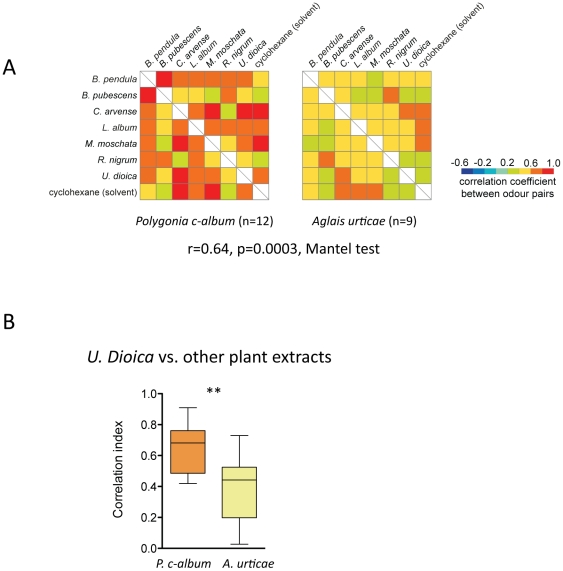
Responses to plant extracts. ASimilarity matrices of responses to plant extracts in P. c-album (left, n = 12) and A. urticae (right, n = 9). The colour coding depicts the median correlation index according to the scale. B The graph shows the correlation between responses to U. dioica and responses to all other plant extracts in the two species (** p<0.001; Mann-Whitney-U test). A box plot shows the median correlation index of a pair of odorants (horizontal line), the 25th and 75th percentile (lower and upper margin of the box) together with the minimum and maximum values (whiskers). Colour coding as in A.